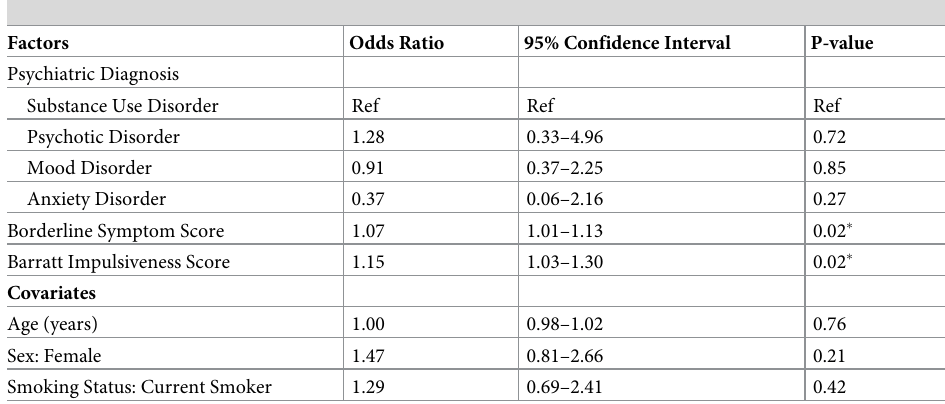
Table 5. Risk factors for attempted suicide: Multivariable logistic regression results (n =